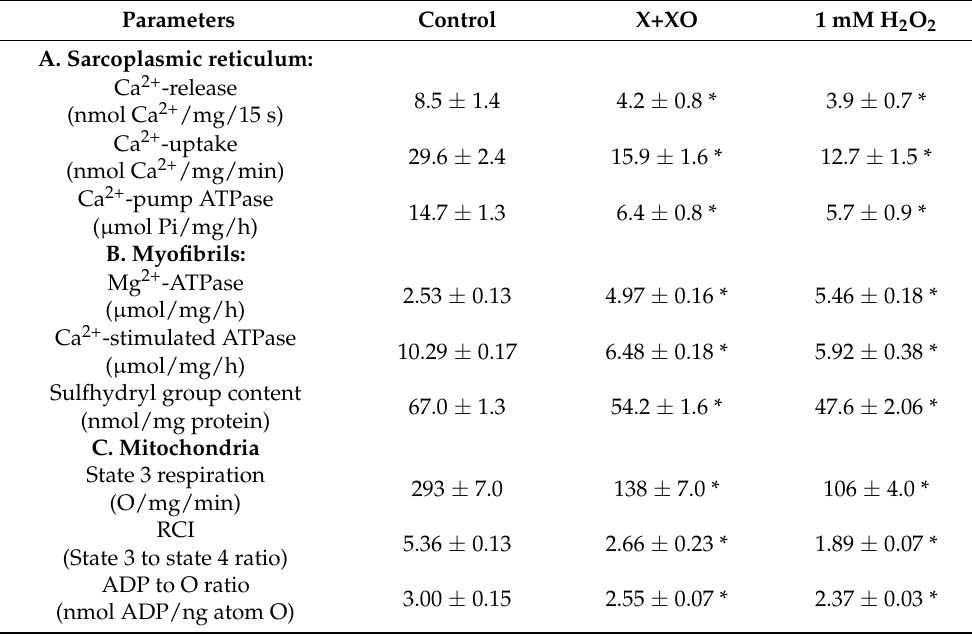
Table 4. Modification of some biochemical activities of cardiac sarcoplasmic reticulum, myofibrils and mitochondria upon incubation for 30 min with some oxyradical generating systems.